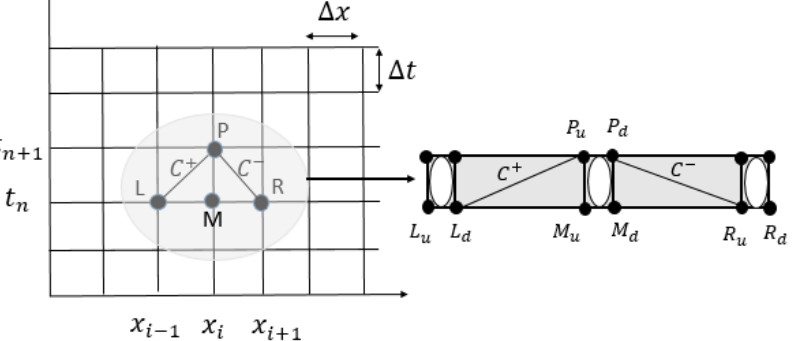
Figure 1. Schematic of computational cells in the method of characteristics and Figure 1. schematic of computational cells in the method of characteristics and DGCM.